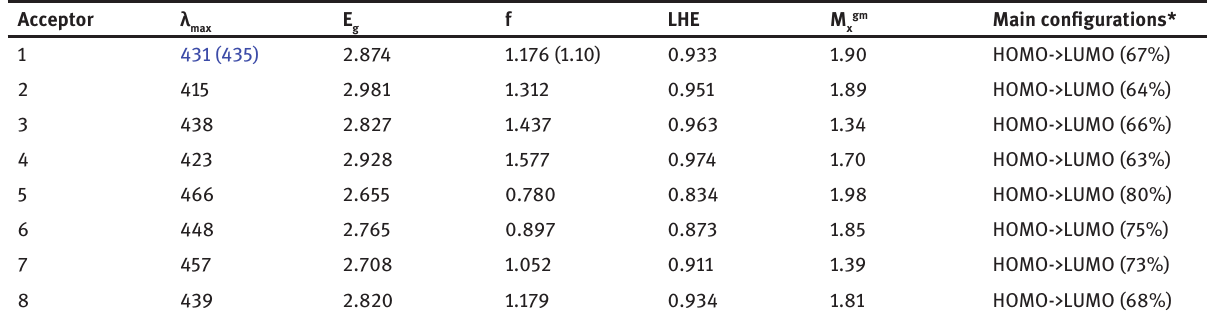
Table 4: Computed maximum absorption wavelengths (λ M a.u.) and transition natures of dyes. (LHE), transition moment ( gm x Acceptor λ